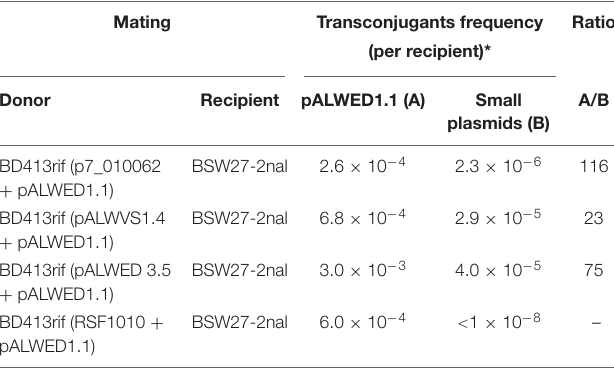
*Average of three experiments.